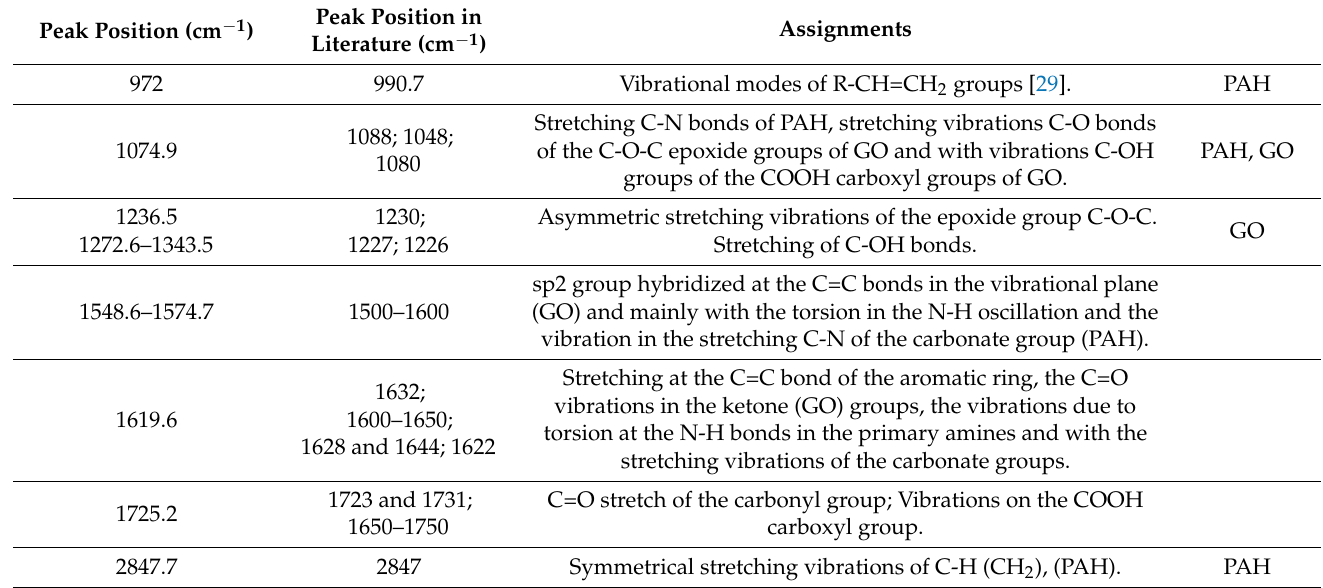
Figure 3. OM images, with different enlargements, of PAH/GO LbL film samples with 1 bilayer ( 1a – 1c ), 2 bilayers ( 2a – 2c ) and 20 bilayers ( 3a – 3c ) deposited on FTO. The white scale bars in the images correspond to 100 μm ( a ), 20 μm ( b ) and 10 μm ( c ). Table 2. Position of the peaks observed in the FTIR spectra of PAH/GO LbL films deposited on CaF 2 substrates and the respective designations of the vibrational modes [18,22,36–39].